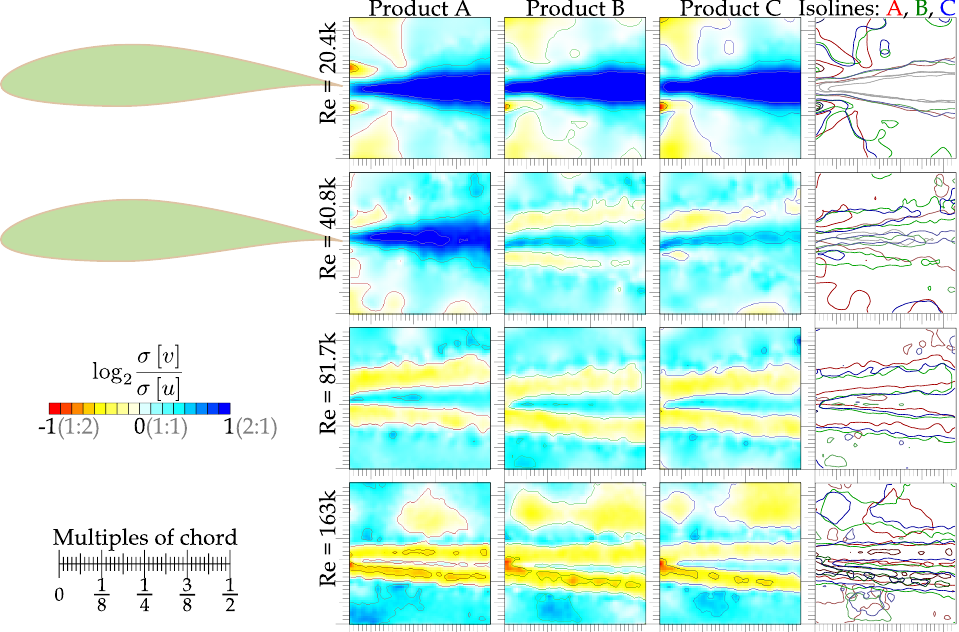
Figure 6. The ratio of cross-stream fluctuations to stream-wise fluctuations obtained behind three different manufactured samples, denoted A, B, and C. Angle of attack α = 0 ◦ in all panels. Redder colors signify a dominance of stream-wise fluctuations, which is typical for areas of continuing boundary layer, while the bluer colors highlight areas of stronger cross-stream fluctuations, which is typical for the so-called true wake